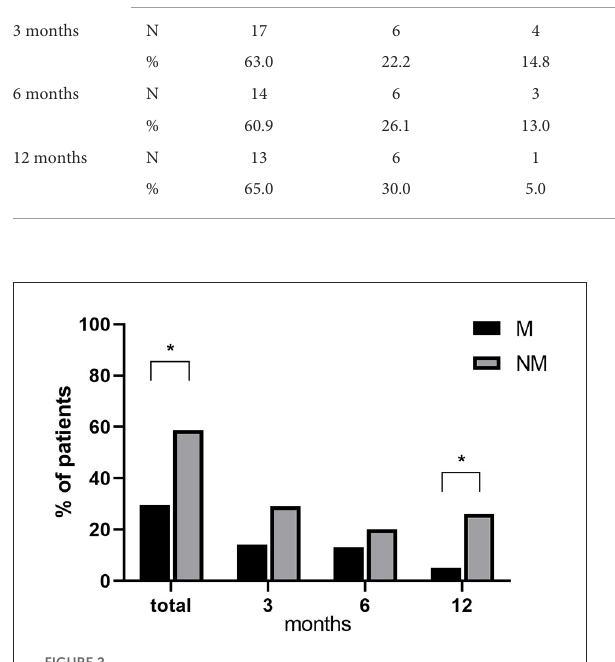
FIGURE2 Differences in drop-out rates between M and NM at different time points. * p < 0.05M vs.